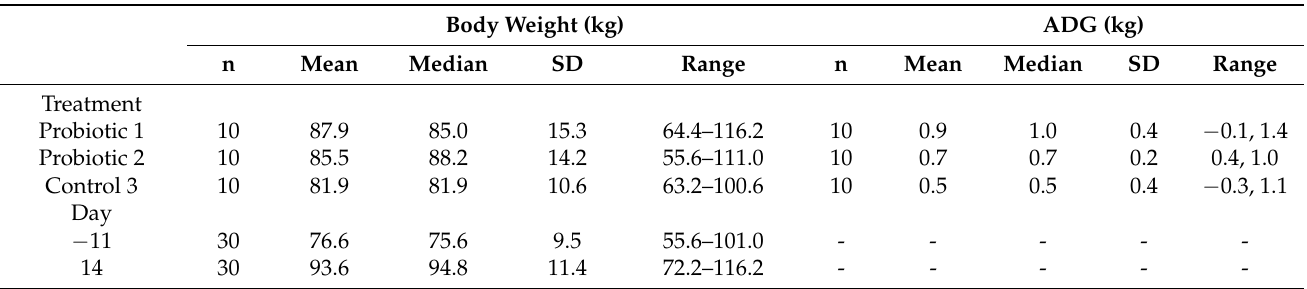
Table 1. Body weight and average daily gain (ADG) of dairy calves supplemented with two probiotic products to reduce Clostridium perfringens .